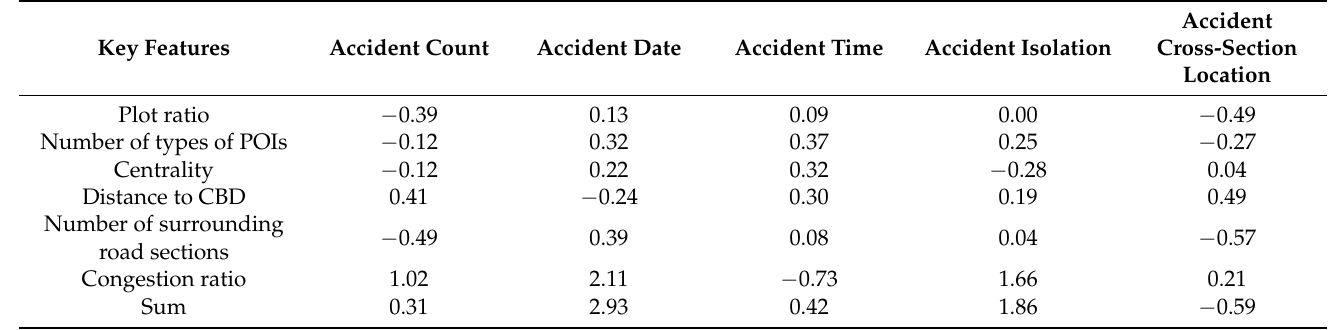
Table 6. W C after